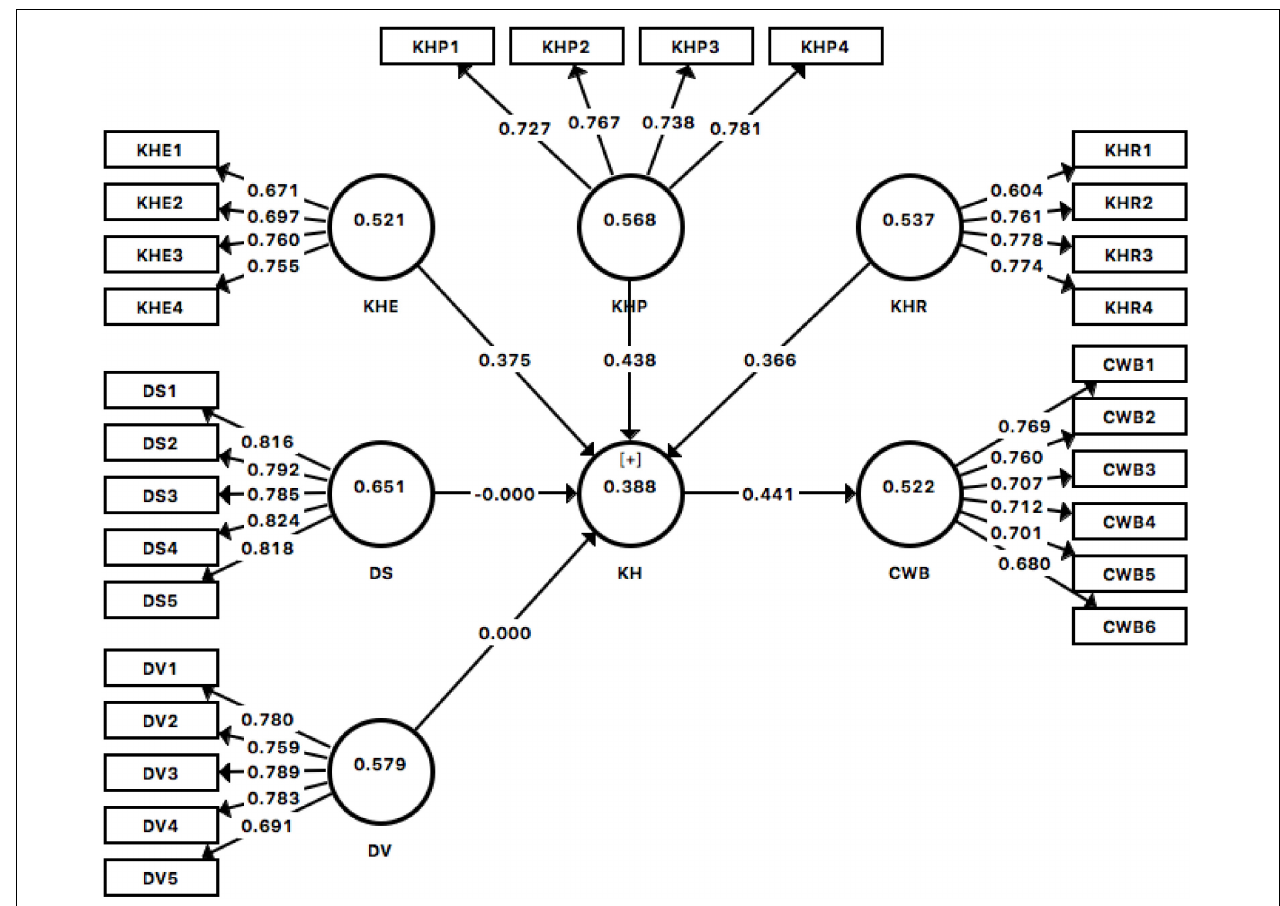
FIGURE 2 | Partial least square (PLS) algorithm